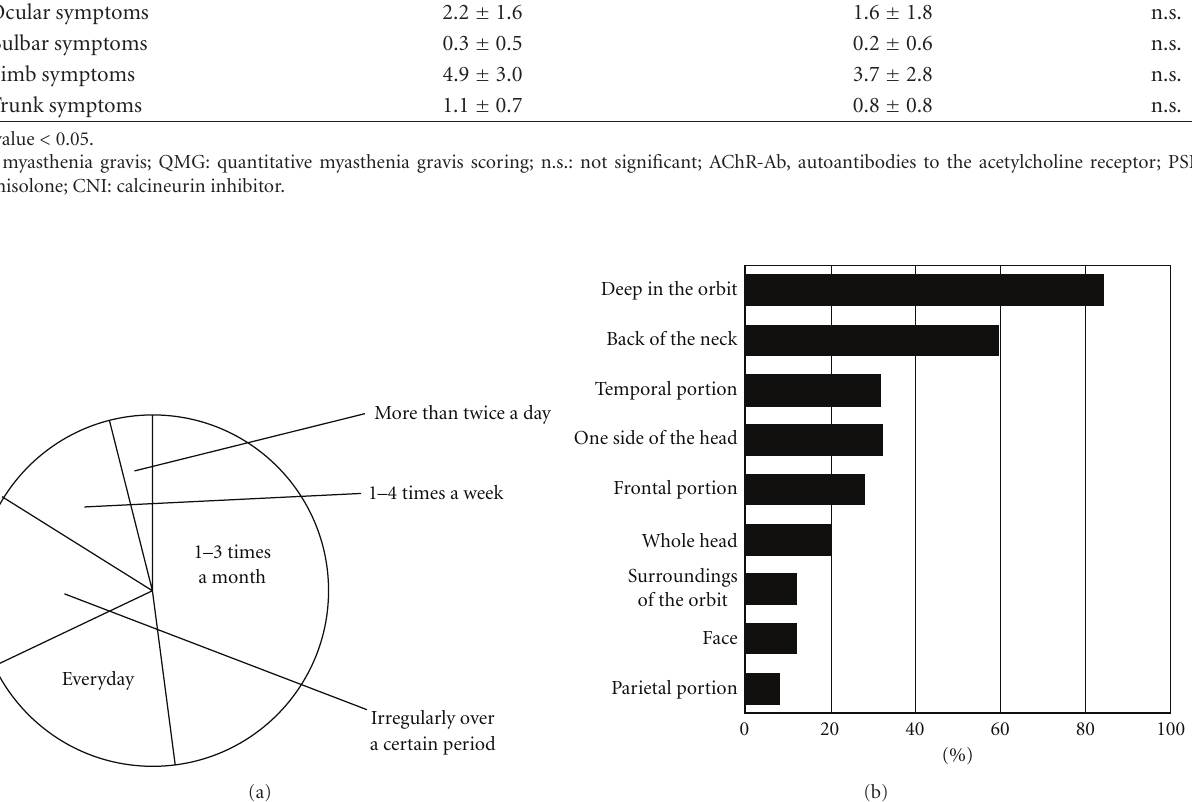
Figure 1: The characteristics of MG-associated headache. (a) The frequency of headache associated with MG ( N = 25). (b) The rates of the patients, who complained of MG-associated headache in each site. Note that headache associated with MG occurs deeply in the orbit most